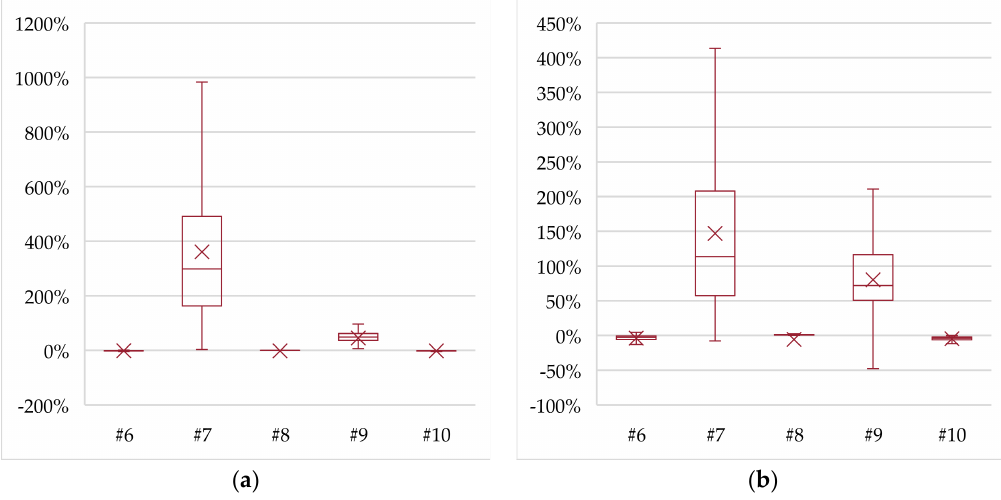
Figure 9. Resulted changes in ( a ) renewable energy use; ( b ) flexible loads.